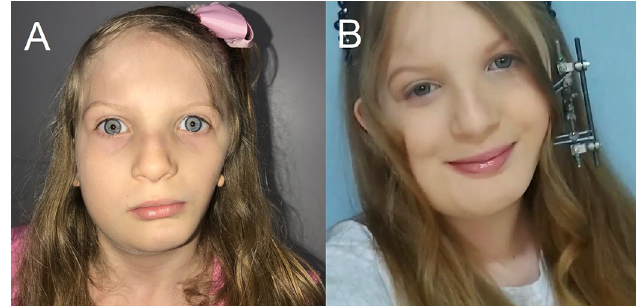
Fig. 8. Before (A) and after (B) bone distraction. Distractor not removed. Note the symmetry of the face. Photographs are not in the same pattern due to pandemics dif fi culties. Parents have sent the recent photo